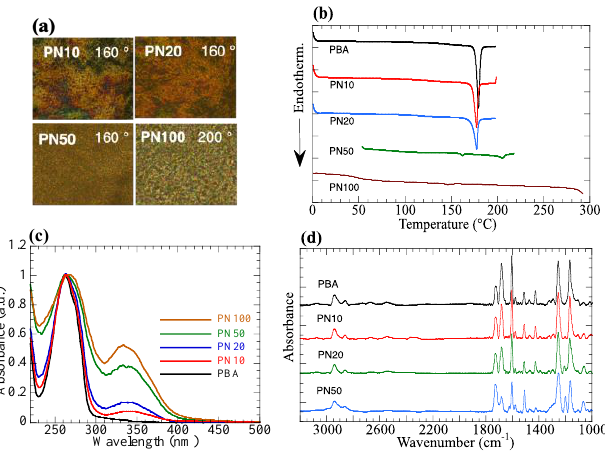
Figure 2. ( a ) POM photographs of LC copolymers. ( b ) DSC second heating curves of the copolymers. ( c ) UV absorption spectra of the copolymer films on quartz substrates. ( d ) FT-IR spectra of the copolymer films on CaF 2